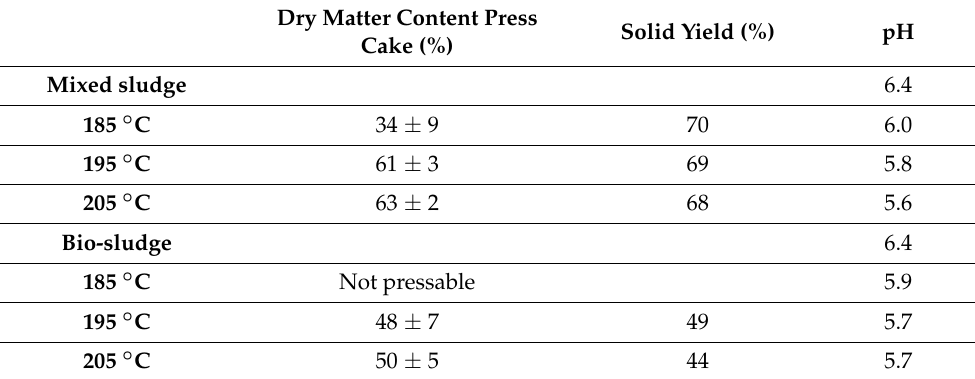
Table 5. Results obtained for the press cake and the pH of the obtained product